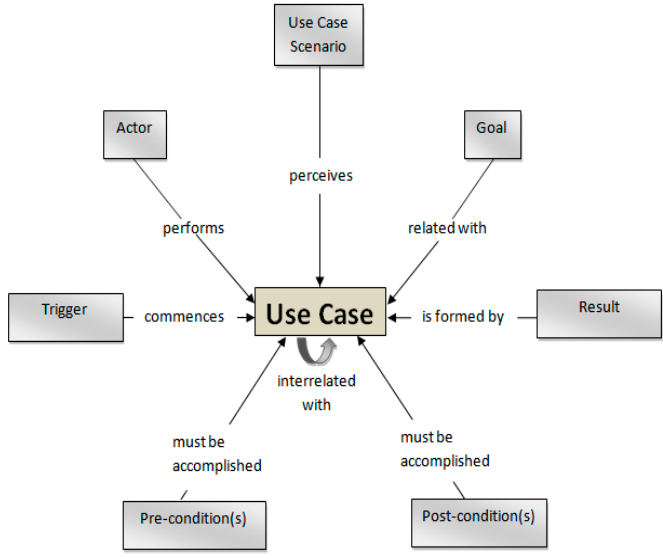
Figure 5. Use case